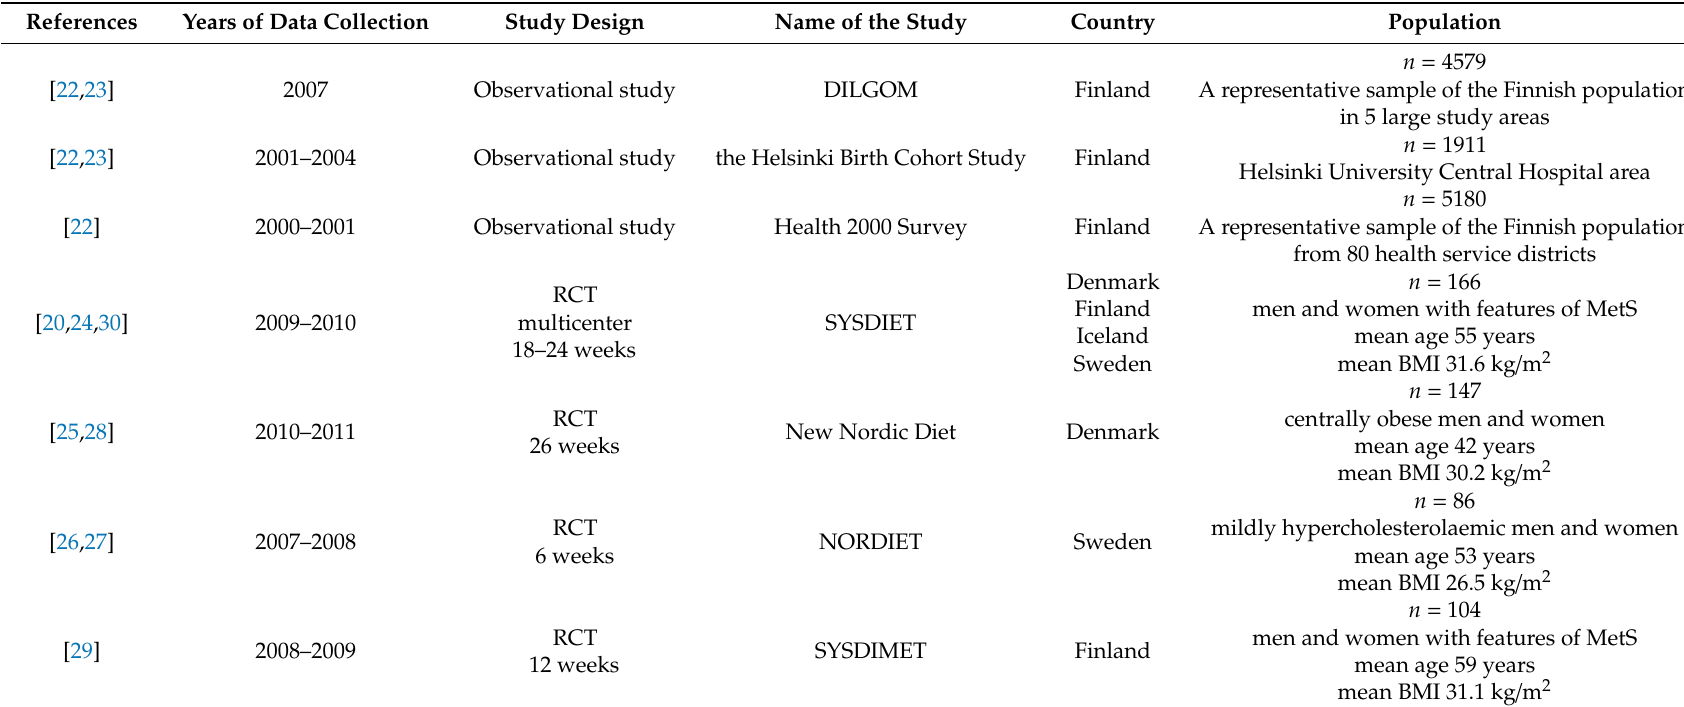
Table 1. Characteristic of studies investigating association or e ff ect of the Healthy Nordic diet (HND) on low-grade inflammation